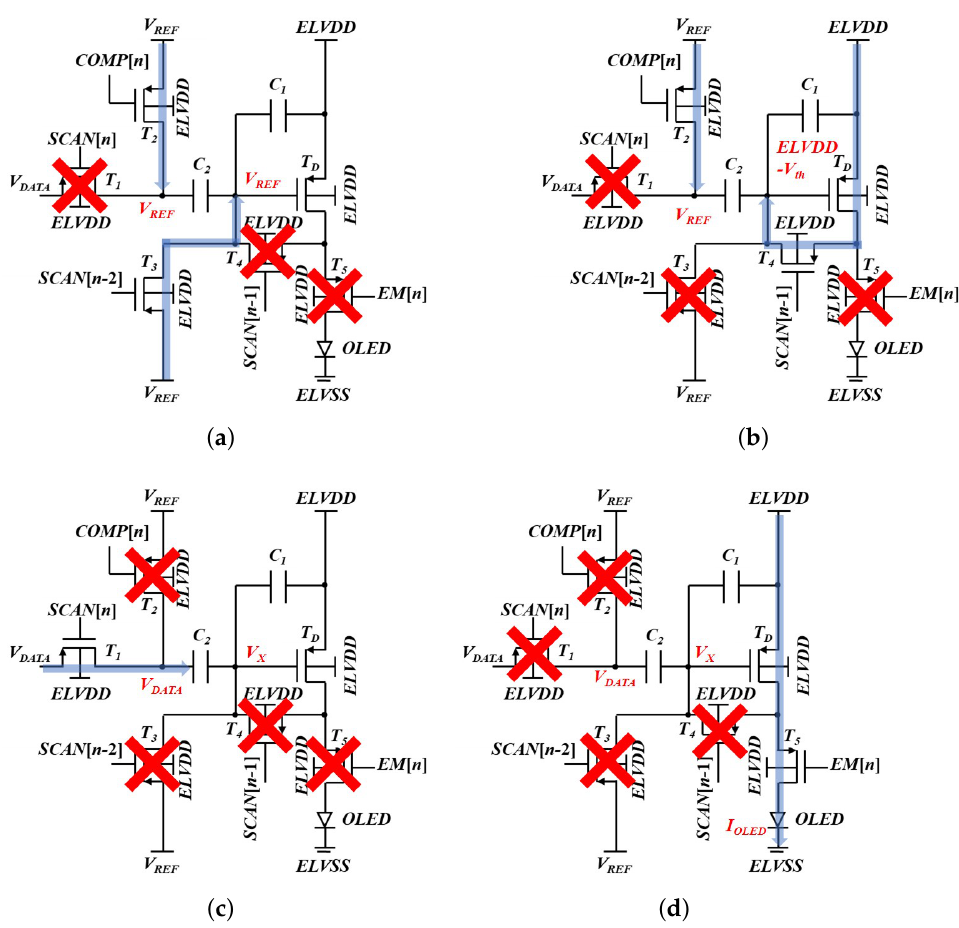
Figure 2. Operation phases of the proposed pixel circuit. ( a ) Initializing. ( b ) V th -sampling. ( c ) Data programming. ( d )